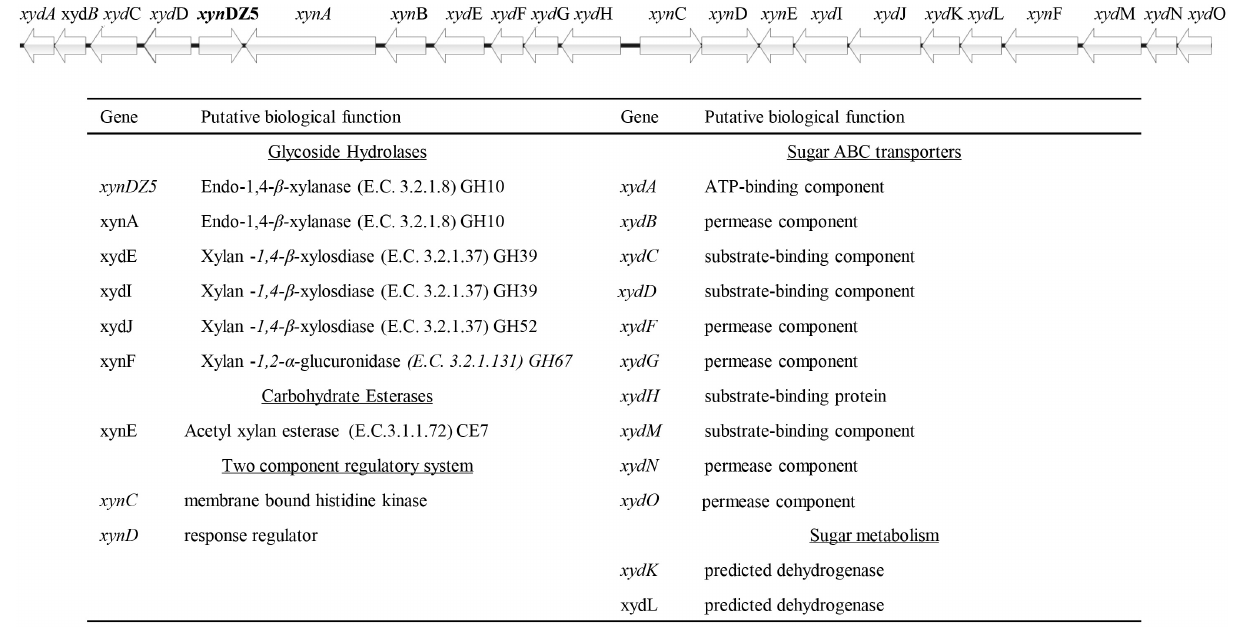
FIGURE 1 | Schematic representation of the putative xylan degradation and utilization genetic locus of the Thermoanaerobacterium sp. found in the sequenced genomic material of the enrichment sample. Each arrow of the graph represents a gene in the locus (upper part) . The functional annotation of these genes is given at the table (lower part)